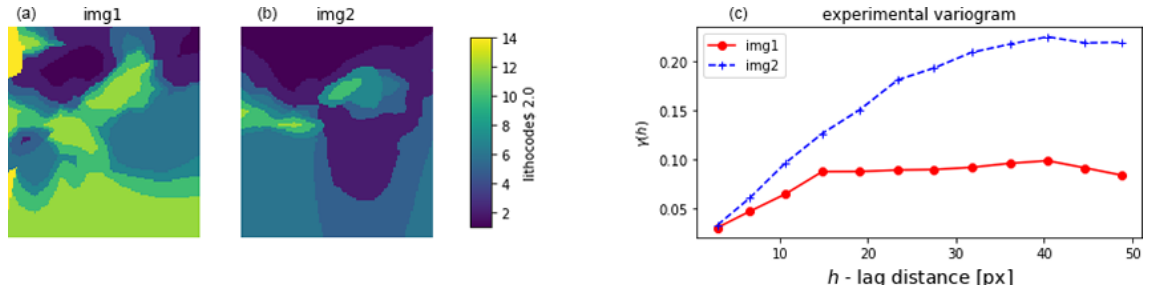
Figure 8. Example of experimental semi-variogram for two lithocode voxets, computed for the lithocode value of 2; (a) and (b) show a horizontal section for each voxet; (c) shows the two corresponding experimental